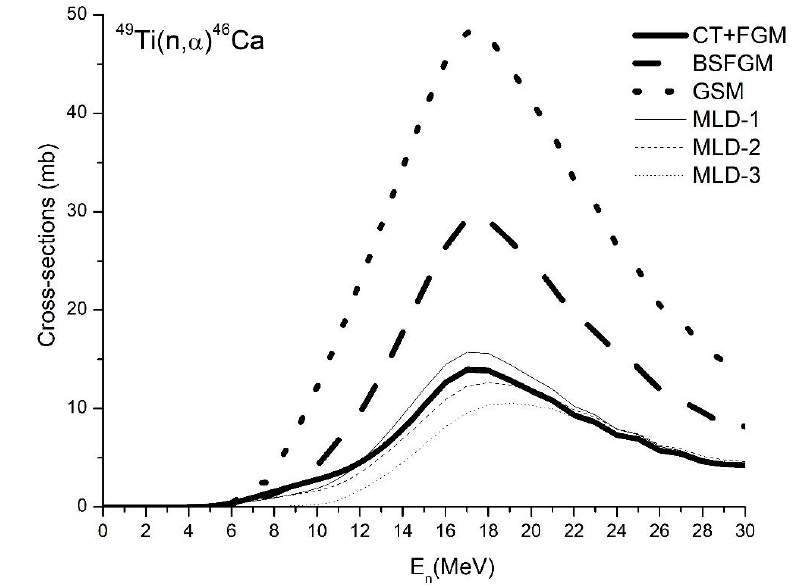
Figure 4: The theoretically calculated excitation functions for 49 Ti (n, α) 46 Ca